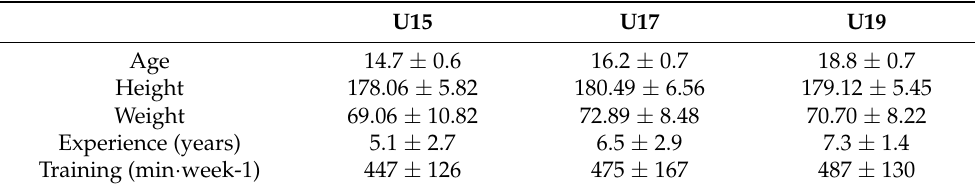
Table 1. Physical characteristics for U15 ( n = 25), U17 ( n = 27), and U19 ( n =